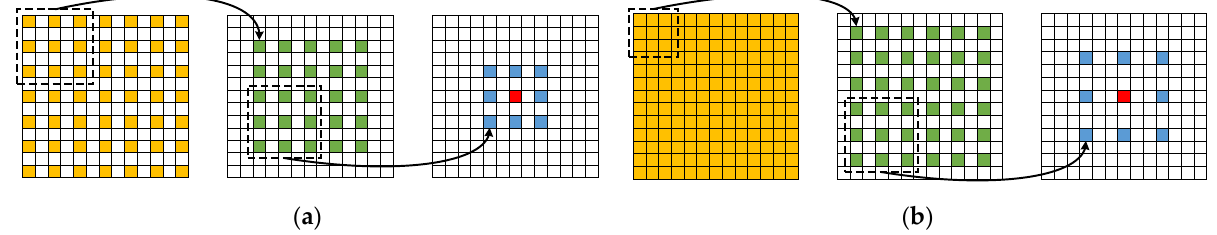
Figure 3. Illustration of the HDC. All the atrous convolution layers with a kernel size of 3 × 3: ( a ) from left to right, continuous atrous convolution with the dilation rate of 2, the red pixel can only get information from the input feature map in a checkerboard fashion, and most of the information is lost; ( b ) from left to right, continuous atrous convolution with the dilation rates of 1, 2, and 3, respectively, the receptive field of the red pixel covers the whole input feature map without any holes or edge loss.